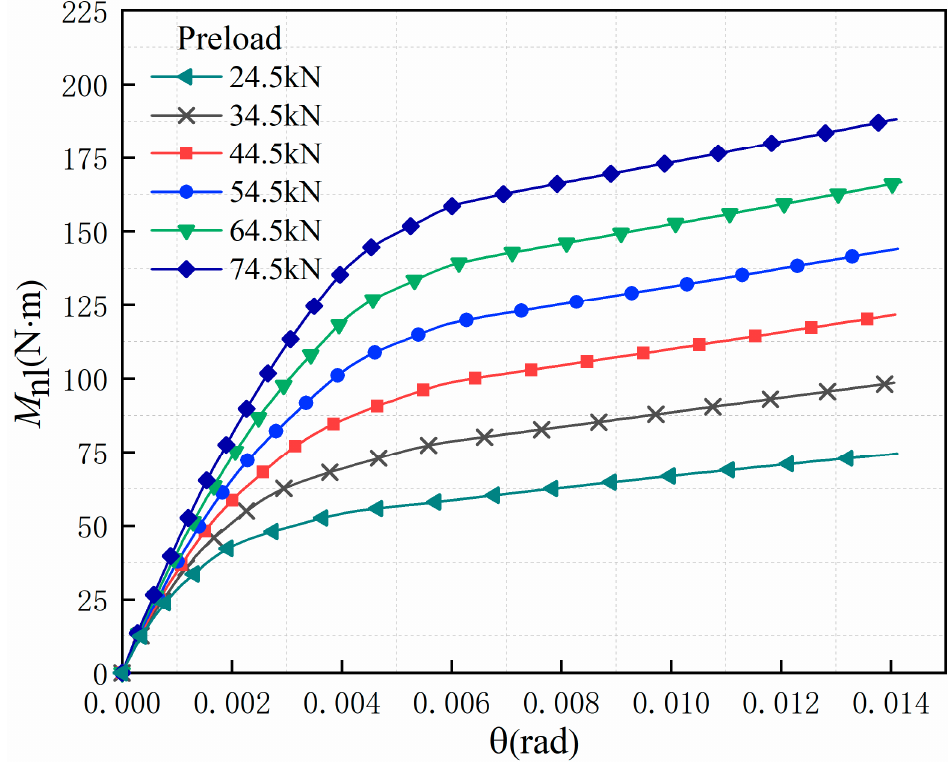
Figure 12. Restoring moment—relative rotation curve of the joint under static transverse load.